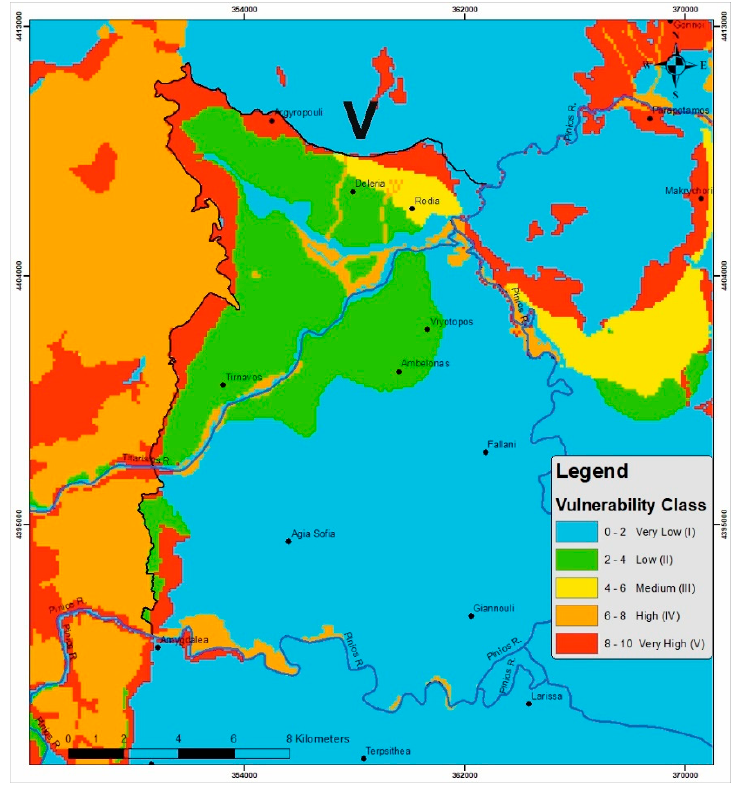
Figure 7. Spatial distribution of vulnerability classes according to the V factor in the study area. In order to compile the V factor distribution map, based on Table S11, the pc values were attributed to a vulnerability class/characterization, corresponding to a V factor